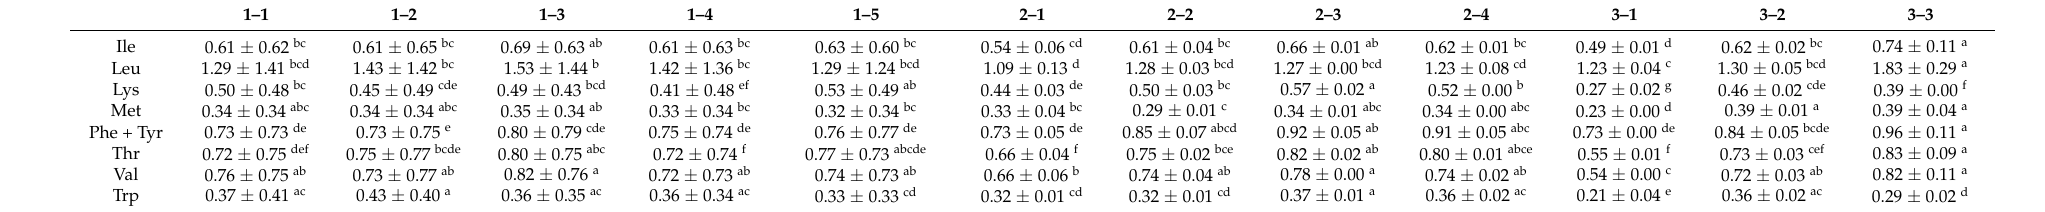
Table 5. CS values of fresh corn from the three provinces.